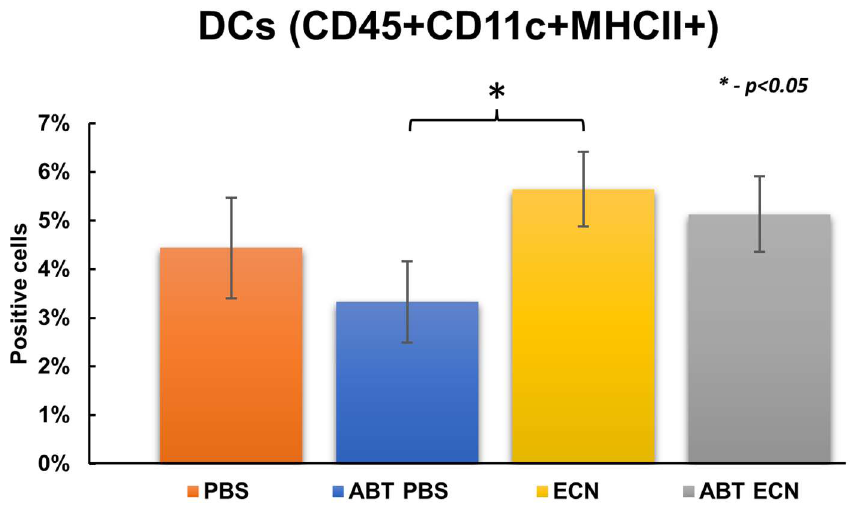
Figure 5. Percent [%] of dendritic cells (DCs) in tumor tissue prepared from antibiotic-treated (ABT) and untreated mice after either bacterial (ECN) or PBS treatments. PBS—PBS-injected group; ABT PBS—antibiotic-pretreated and PBS-injected group; EcN—EcN/pMUT-gfp Kn r -injected group; ABT EcN—antibiotic-pretreated and EcN/pMUT-gfp Kn r -injected group. Data are representative of three independent experiments ( n = three mice per group). The statistical significance was calculated by the Student’s t -test where * indicates p < 0.05.